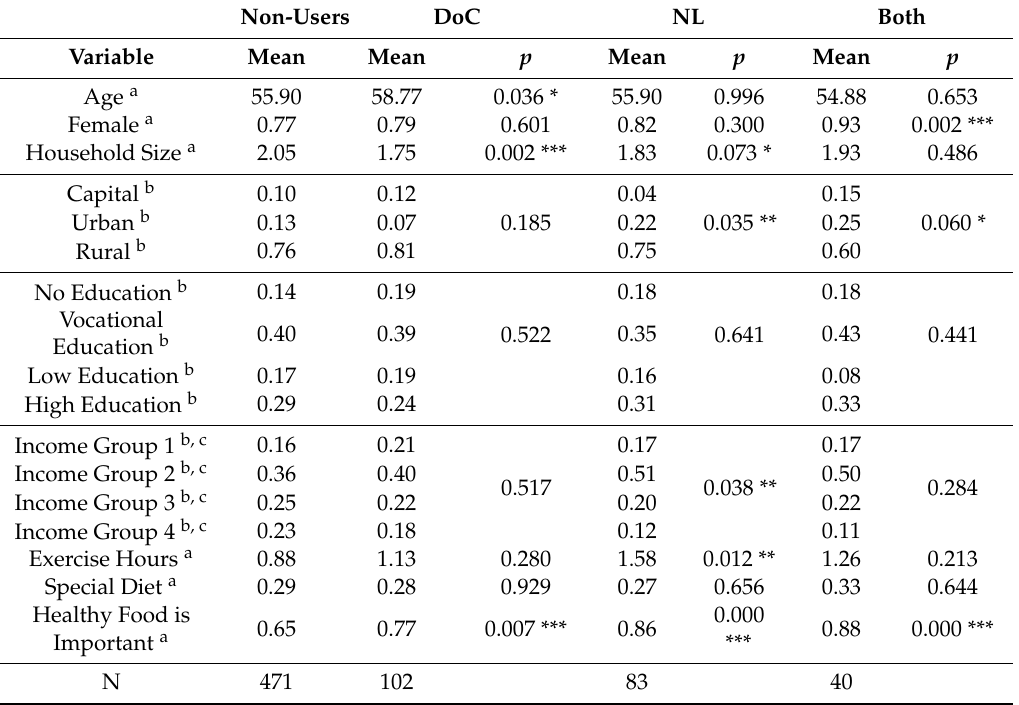
Table A3. Summary statistics for DoC, NL and Both switchers and non-users in